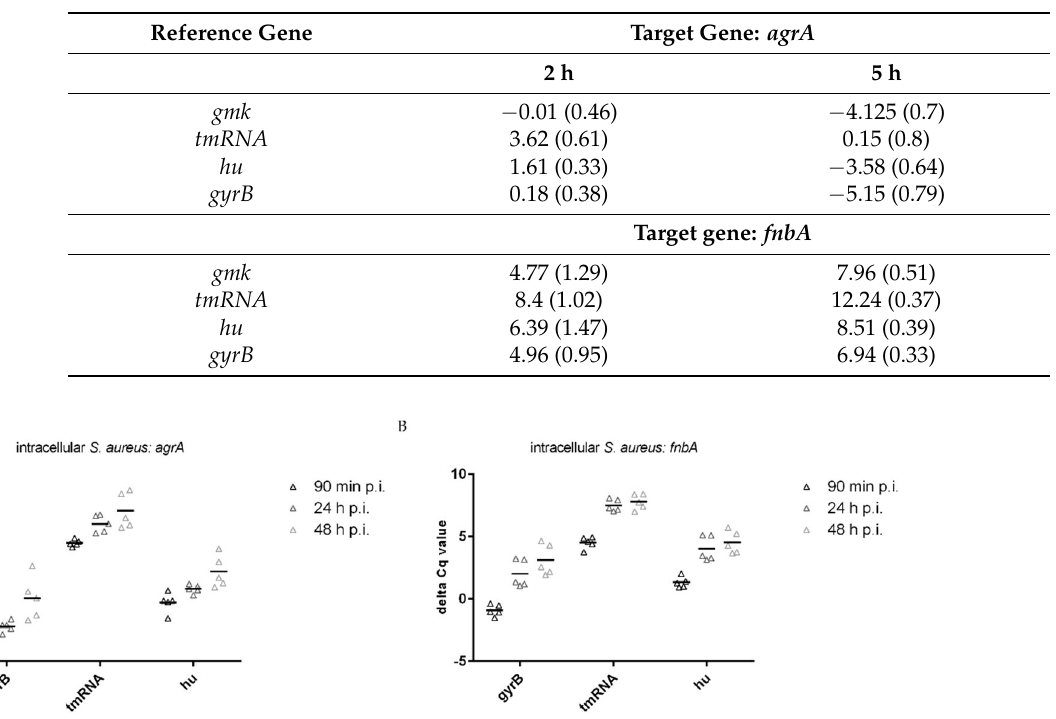
keeping genes in S. aureus from culture after 2 h and 5 h of incubation (condition I). keeping genes in intracellular S. aureus at 90 min, 24 h, and 48 h postinfection (condition II).